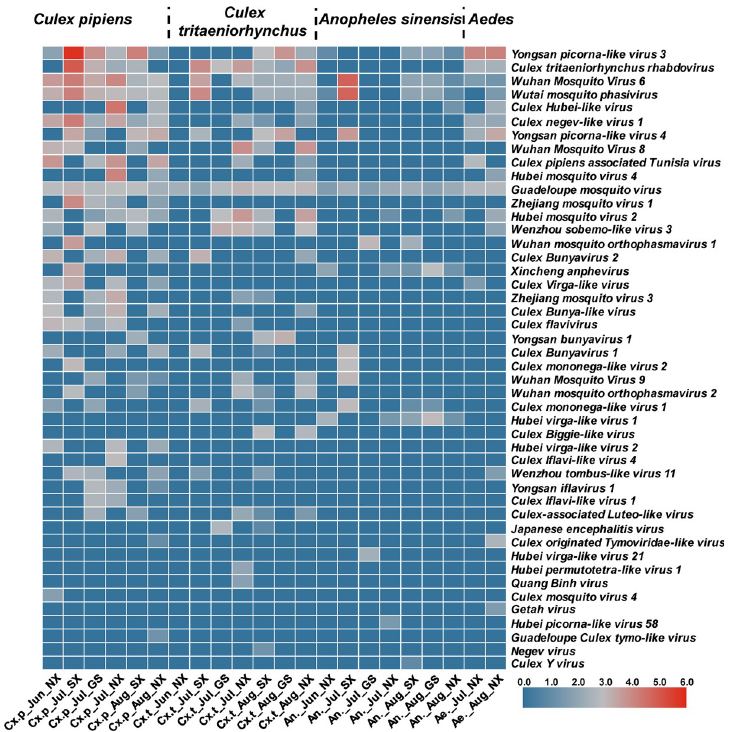
Fig 3. Heatmap showing sequence reads of selected mosquito-borne viruses in each pool. The names of the 46 viral species are listed in the right column. Mosquito species are shown at the top. Pool information is provided in the bottom row. The colors represent the base-10 logarithm of sequence read number, from blue (low read number) to red (high read number).